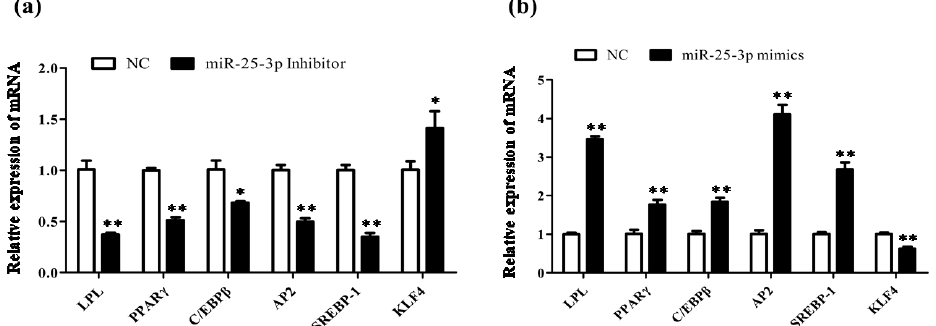
Figure 4. Overexpression of miR-25-3p promotes goat intramuscular differentiation. (a) The mRNA expression levels of key adipogenic regulatory genes were detected after transfected miR-25-3p inhibitor in goat intramuscular preadipocytes. (b) The mRNA expression levels of key adipogenic regulatory genes were detected after transfected miR-25-3p mimics in goat intramuscular